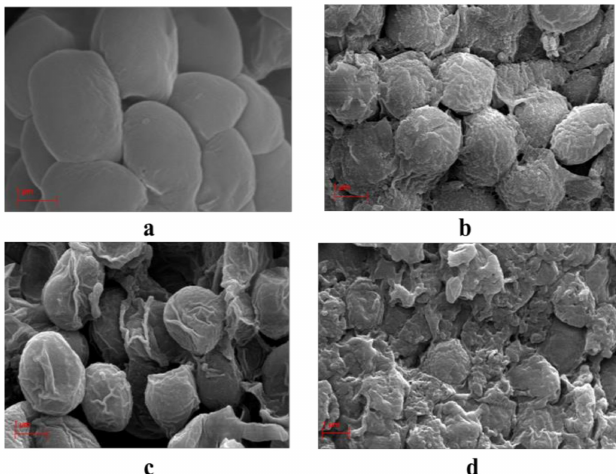
Figure 10. SEM micrographs (10K magnification) of the microalgal biomass before and after various lipid extraction methods: ( a ) original microalgal cell of Nannochloropsis sp., ( b ) microalgae cells after Soxhlet extraction, ( c ) microalgae cells after B&D method and ( d ) microalgae cells after MAE-brine technique at optimum extraction